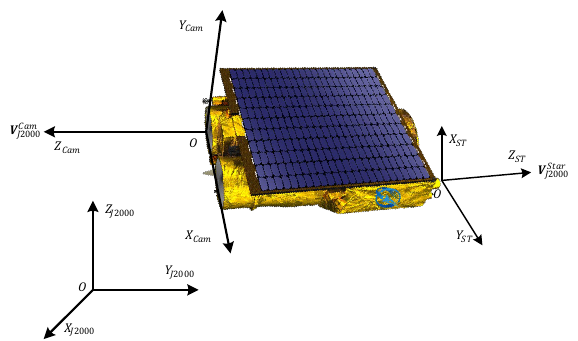
Figure 3 . The relationship between camera coordinate system, star sensor coordinate system and inertial coordinate